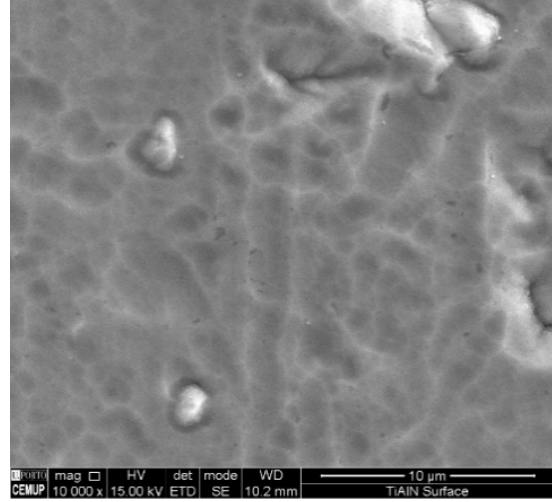
Figure 6. Energy dispersive spectroscopy (EDS) spectrum collected during SEM observations presenting the TiAlN composition.